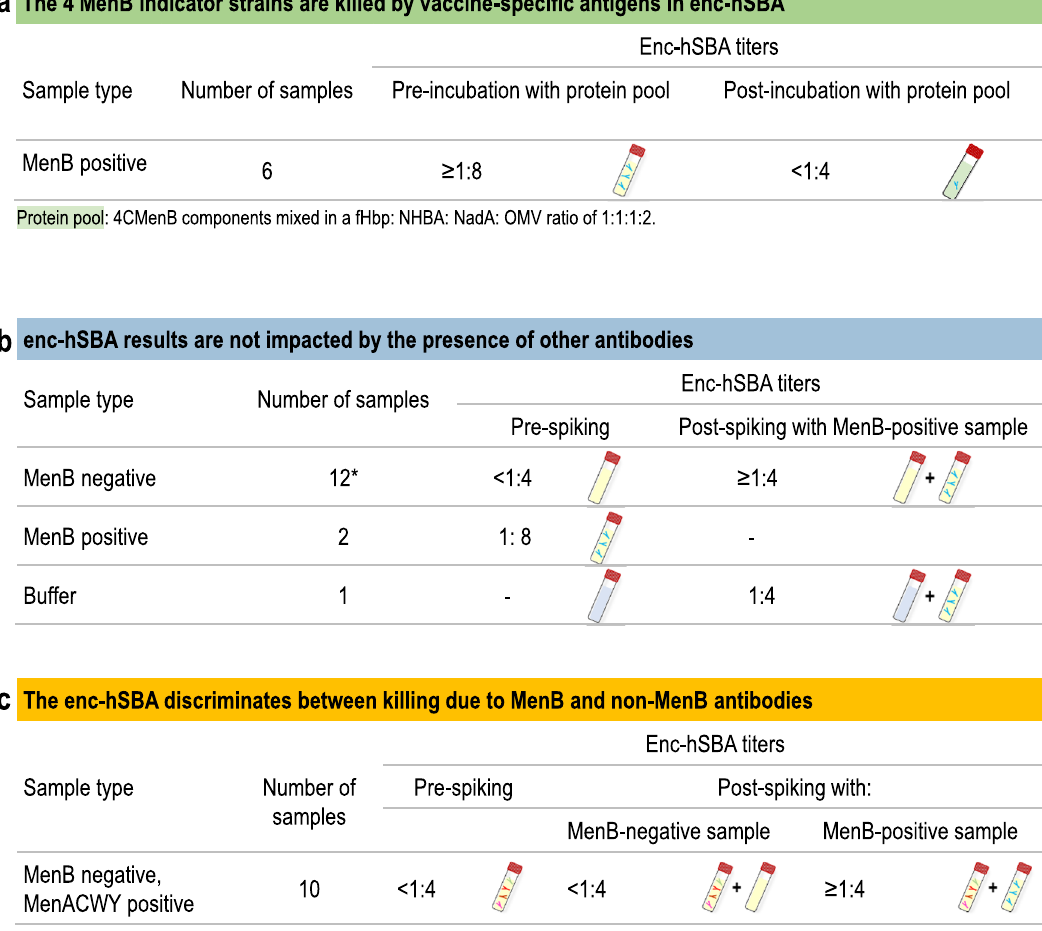
Fig. 3 Enc-hSBA speci fi city. Enc-hSBA speci fi city evaluated by inhibition experiments ( a ) andsensitivity evaluated by spiking experiments ( b , c ), using testing against the 4 indicator strains. Enc-hSBA, serum bactericidal activity assay using endogenous human complement; MenB, serogroup B meningococcus; 4CMenB, 4-component meningococcal serogroup B vaccine; fHbp, factor H binding protein; NadA, Neisseria adhesin A; NHBA, Neisserial Heparin Binding Antigen; OMV, outer membrane vesicles; MenACWY, serogroup A, C, W, and Y meningococci. Note: *From 2 different sets of